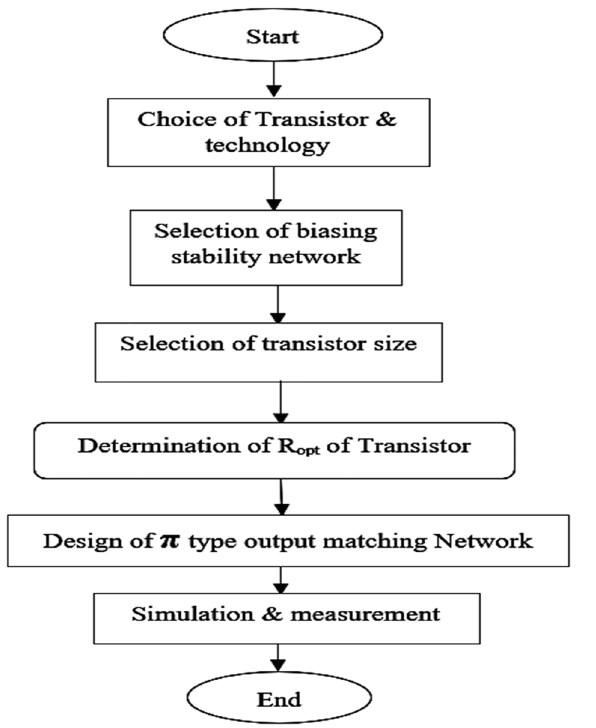
Figure 3. Flow chart of PA’s design